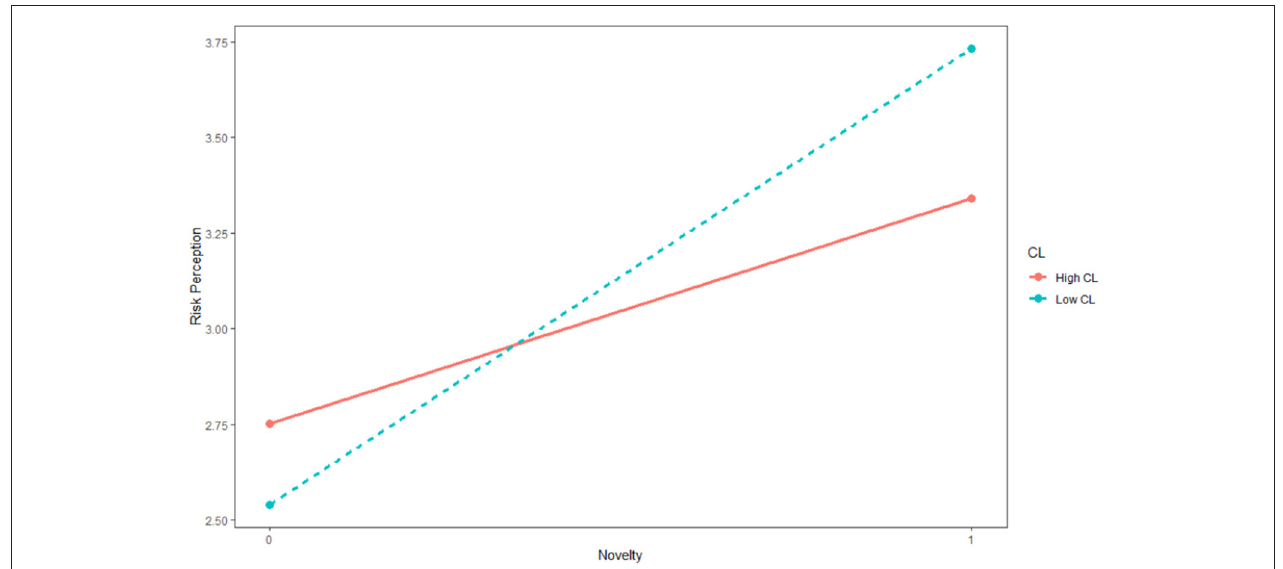
FIGURE 2 | The interactive effect of opportunity novelty and construal level on risk